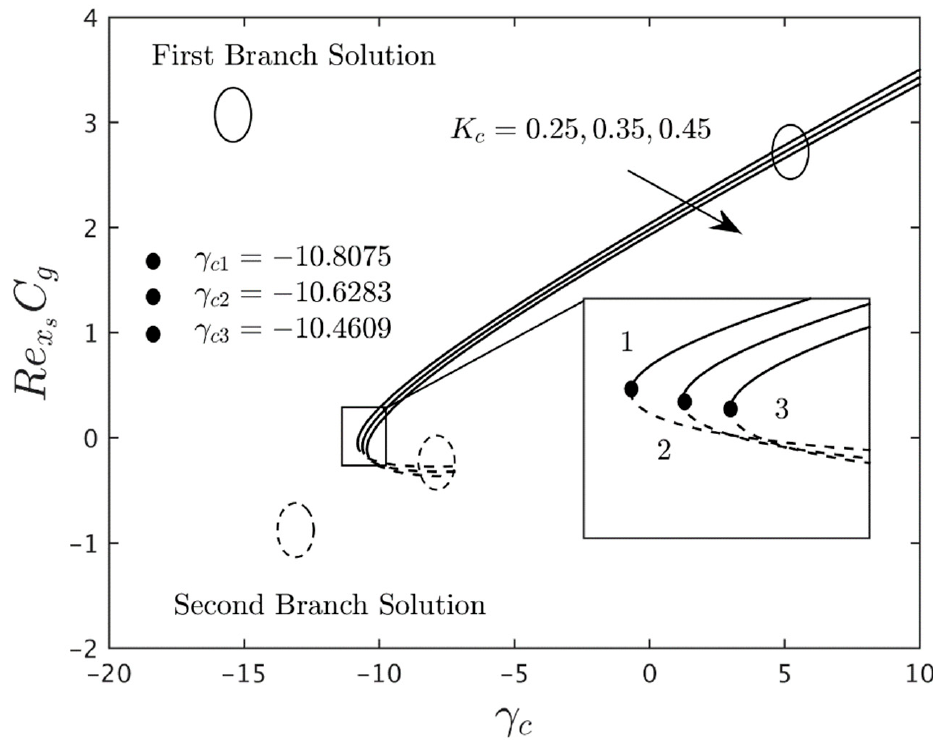
Figure 12. Variation of the couple stress coefficient with γ c for the several values of K c .